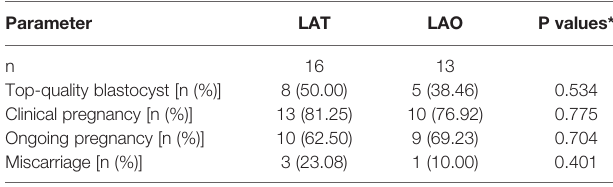
TABLE 4 | Characteristics and clinical outcomes of blastocyte